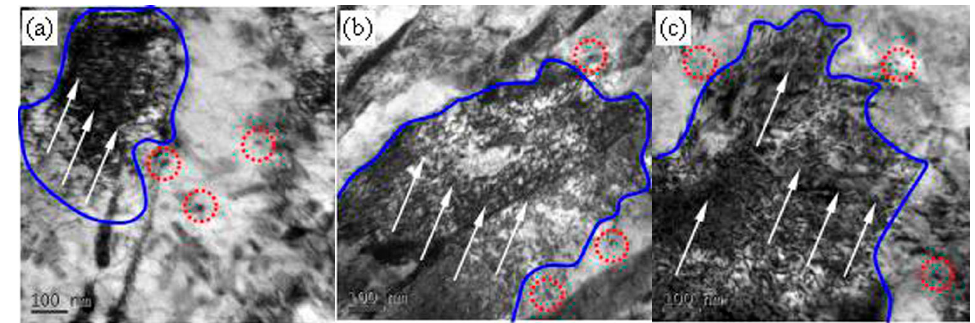
Figure 14. The induced radiation observed by high-power TEM images when the cumulative fluences of the 5140 alloy steel at 480 °C were irradiated with 2 × 10 14 protons/cm 2 ( a ), 2 × 10 15 protons/cm 2 ( b ), and 2 × 10 16 protons/cm 2 . ( c ) Changes in the density of dislocation loops and dislocation clusters in the microstructure caused by the damage.